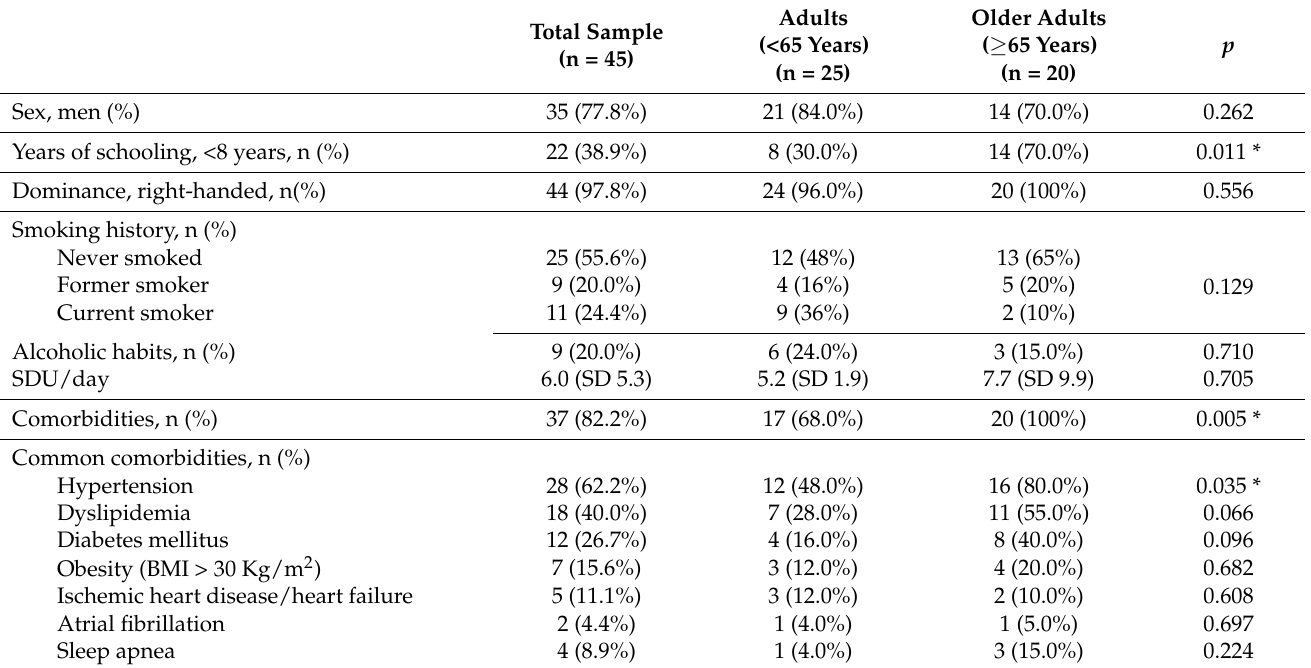
Table 2. Baseline demographic and clinical characteristics of